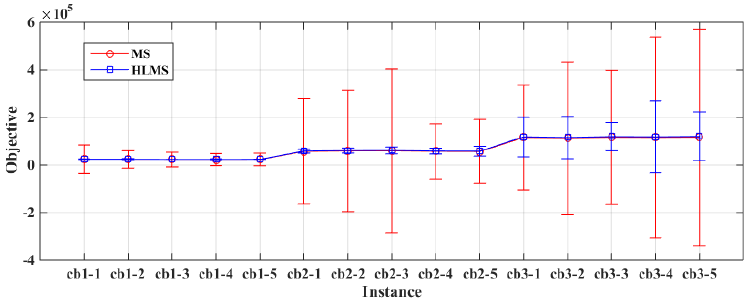
Figure 5. The error bars (Variance) for MS and HLMS on Test set III (cb1–cb3).